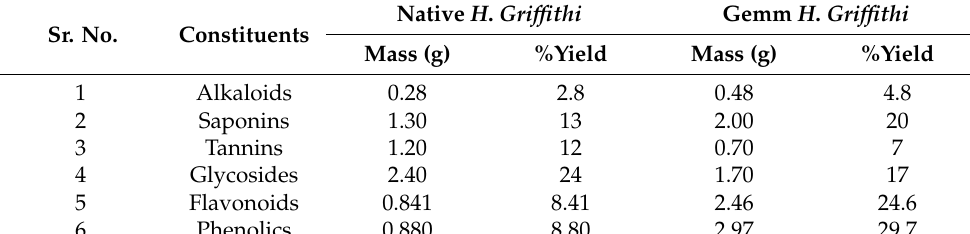
Table 1. Extraction and quantification of phytochemicals in native and gemm extracts of H . griffithi .